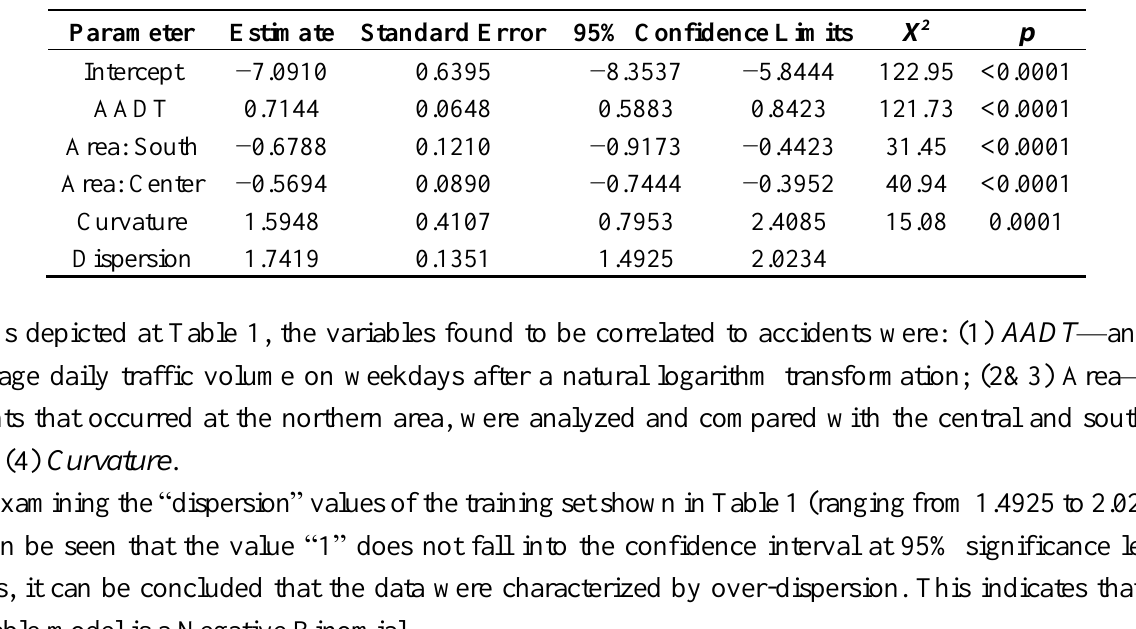
Table 1. GENMOD procedure results for the training model (two-thirds of the data for segments of 500 m in